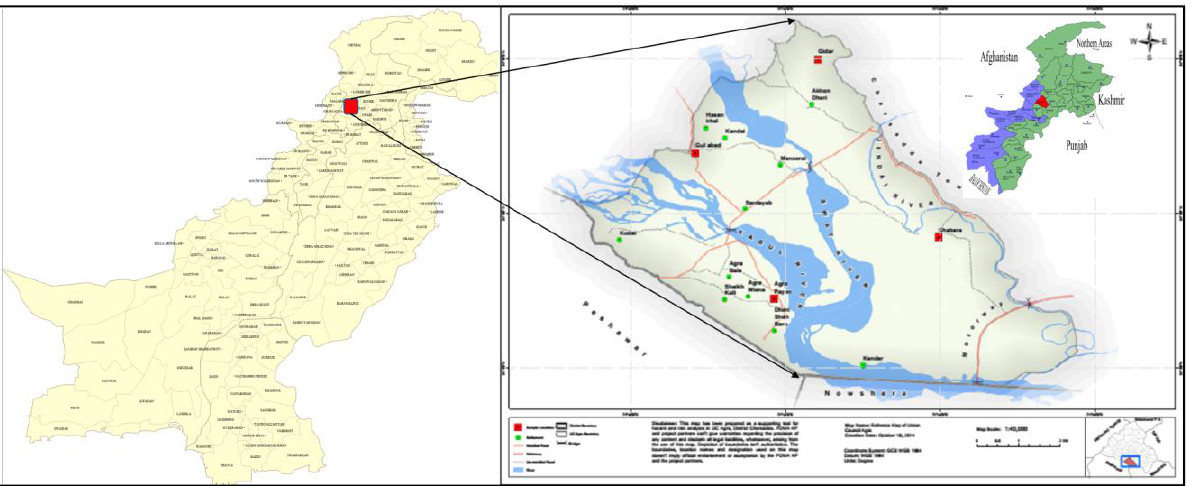
Figure 1. Location Map of Union council